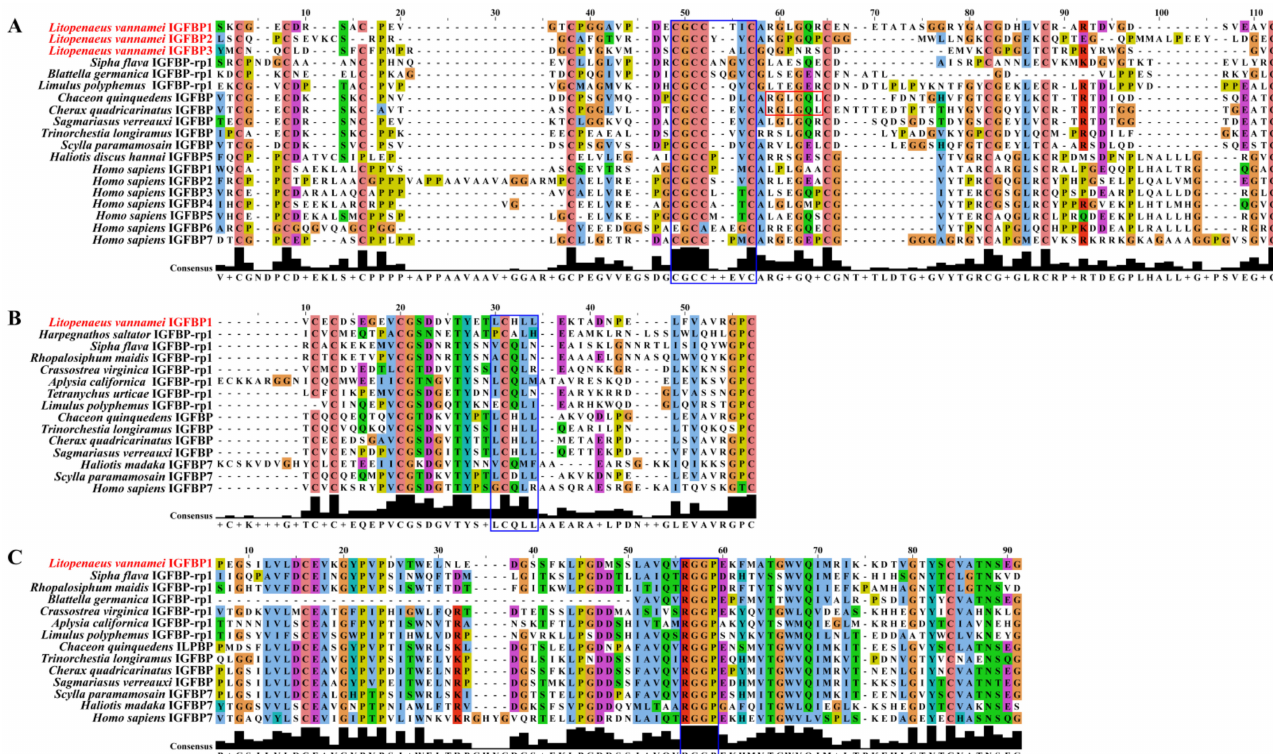
Figure 2. Multiple sequence alignment of the three domains of the IGFBP protein sequence. ( A ) N-terminal insulin growth factor binding (IB) domain: the highly conserved motif is framed in blue (CGCCxxC), except for Homo sapiens IGFBP6; the motifs of other species are highly conserved. The conserved decapod motif is framed in red (RxLxxL). ( B ) Mid-region Kazal domain: the conserved motif is framed in blue (LxxLL). This motif is different from other species, and the L site in this motif is not particularly conserved. ( C ) C-terminal immunoglobulin C-2 (IGc2) domain: the highly conserved motif is framed in blue (RGGP). This motif is extremely conserved in most